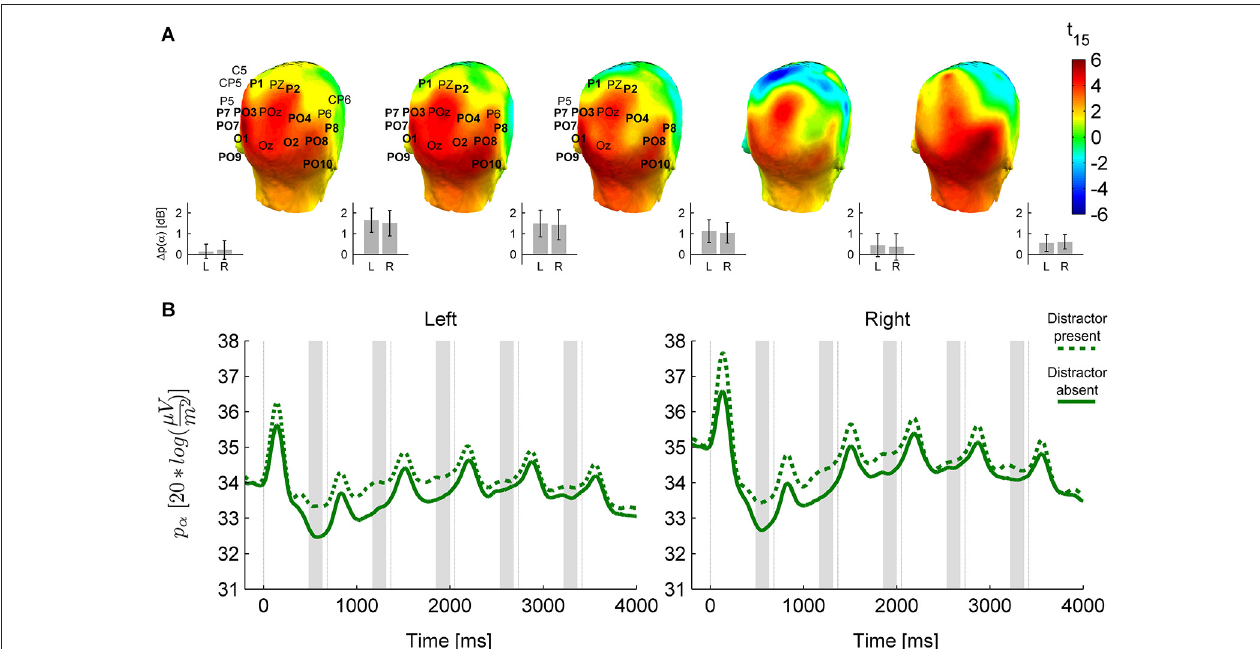
pools of these electrodes from either hemisphere (Left: P7, PO7, PO9, PO3, O1, P1; Right: P8, PO8, PO10, PO4, O2, P2). Insets on the lower right side of each head plot depict means and 95% confidence intervals of the distractor-related difference in the Left and Right pools; on the left of the figure, this is also shown for the pre-S1 interval. (B) Temporal evolution of alpha activity in the presence and absence of distractors in the Left and Right pool selected from the distractor-effect